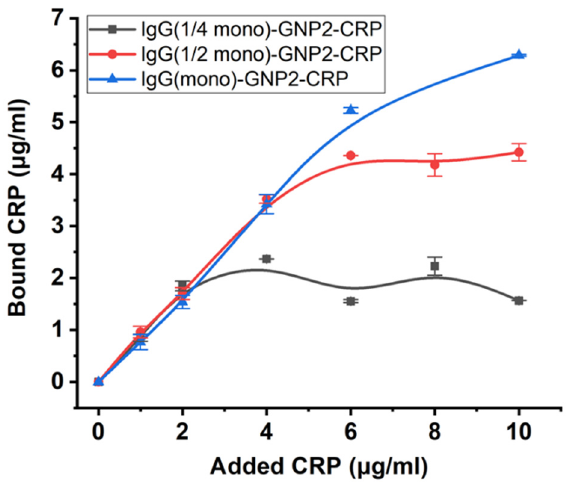
Figure 6. CRP binding to conjugates of GNPs with 23.5 nm diameter containing 5.1, 2.6, and 1.85 µ g/mL of bound antibodies. Dependence of bound CRP concentrations ( y -axis) on added CRP concentrations ( x -axis).